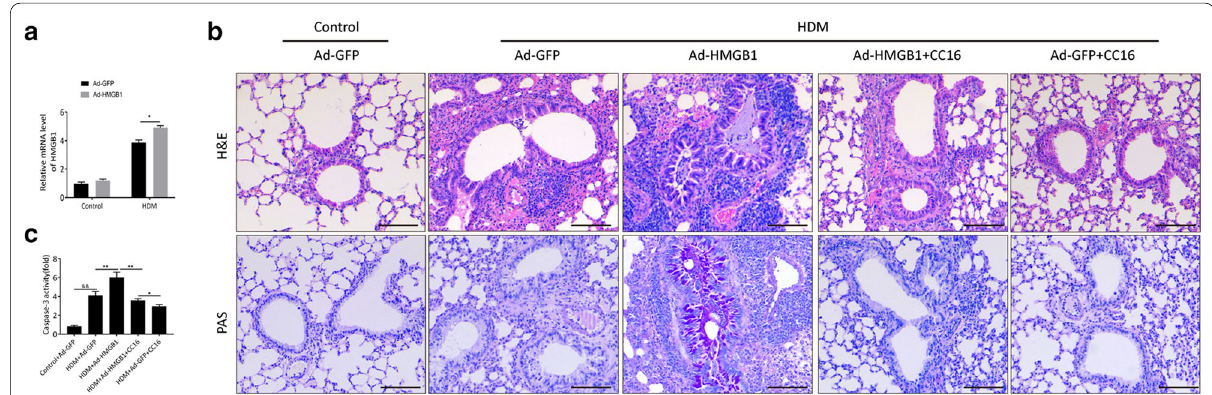
Fig. 7 HMGB1 overexpression abolishes the protective effect of CC16 against HDM-induce airway damage. HMGB1 overexpression in mouse lungs was induced by intratracheally injection of Ad-HMGB1 vector. Ad-GFP was used as the negative control as shown in Fig. 5. Then the gene-modified mice was sensitized and challenged by HDM with or without CC16 (10 g/g) administration. a Relative mRNA levels of HMGB1 in mouse lungs from different groups. b Representative images of lung tissues showed airway wall thickening, mucous hyperplasia and collagen deposition. c The caspase-3 activities of the lungs in different treatment groups. Data are expressed as && p < 0.01 vs. control Ad-GFP group; # p < 0.05 vs. + HDM Ad-GFP group; ## p < 0.01 vs. HDM Ad-GFP group; *p < 0.05 vs. HDM Ad-HMGB1 CC16 group; **p < 0.01 vs. HDM Ad-HMGB1 CC16 + + + + + +